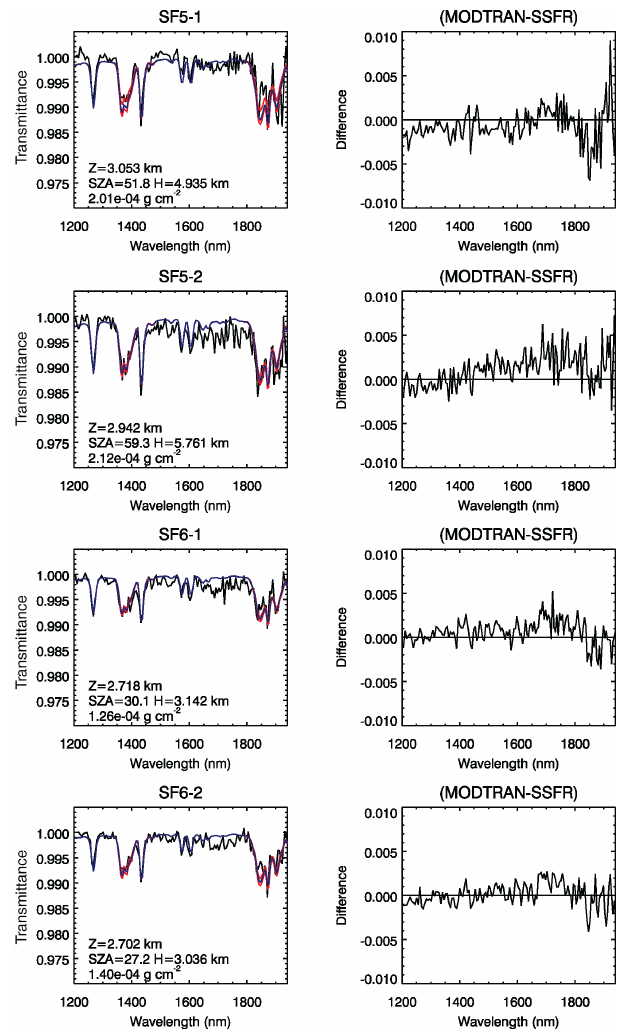
Figure 8. Same as Fig. 6 for profiles during the fifth and sixth AT- TREX science flights.